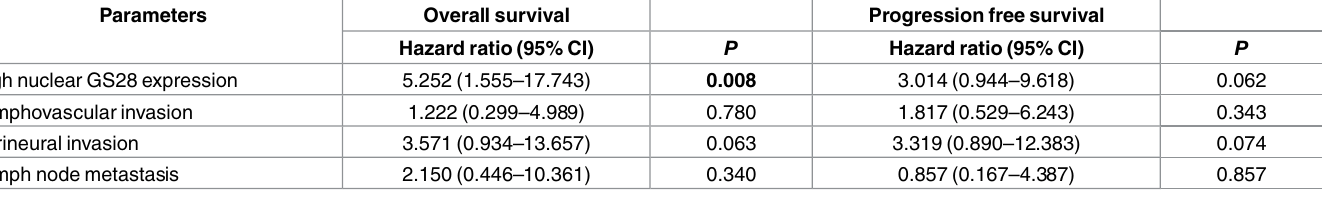
Table 4. Multivariate Cox regression analysisfor overall survivaland progression-free survivalin stageT1 subgroup(N = 121) of cervical cancer patients.